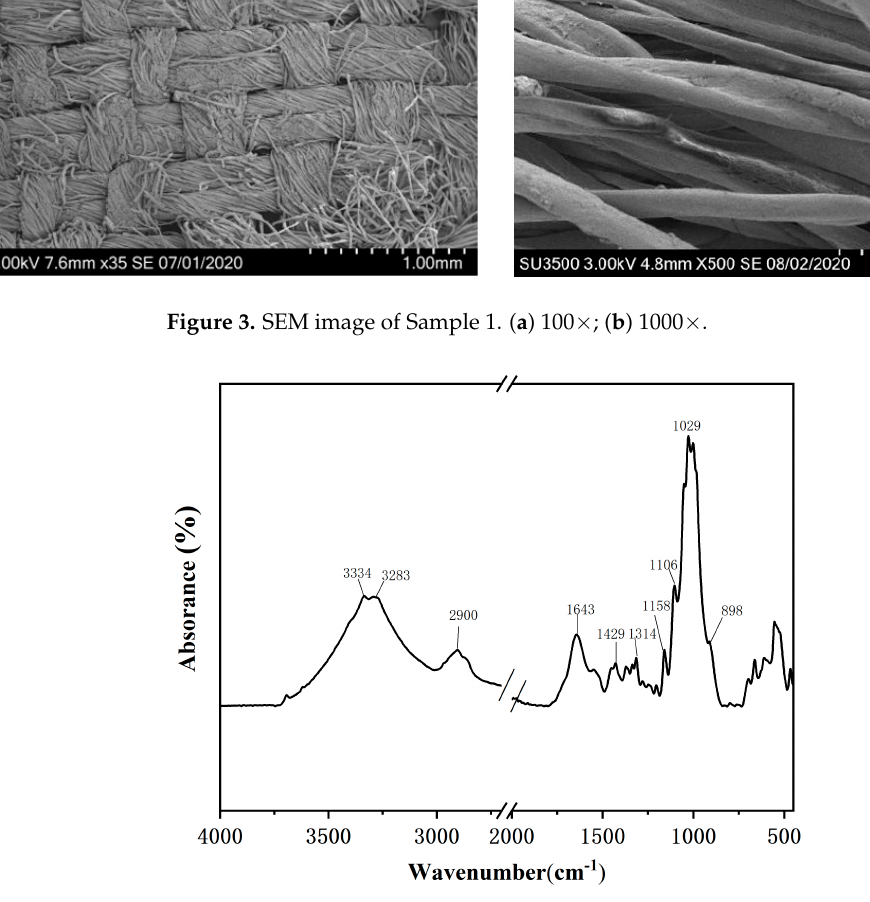
Figure 3. SEM image of Sample 1. ( a ) 100×; ( b ) 1000×.